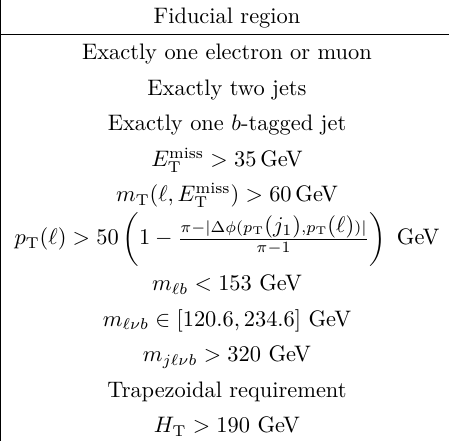
Table 2 . Summary of the signal selection criteria, applied to particle-level objects, for defining the fiducial